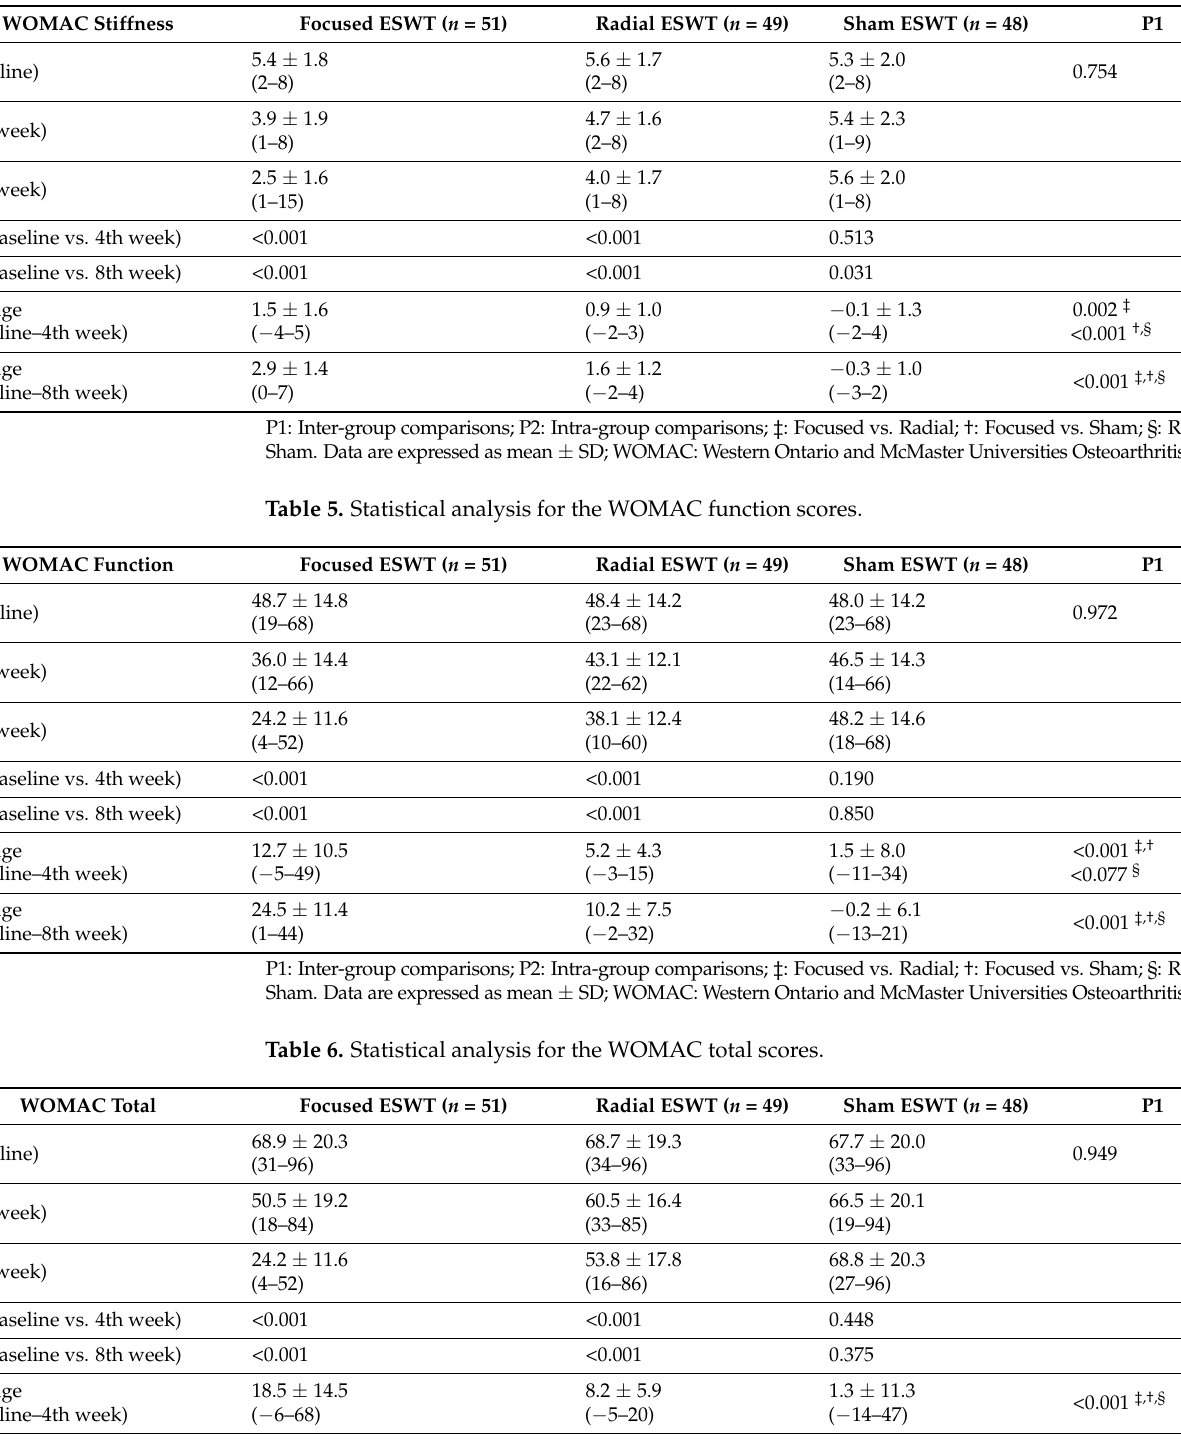
Table 4. Statistical analysis for the WOMAC stiffness scores.